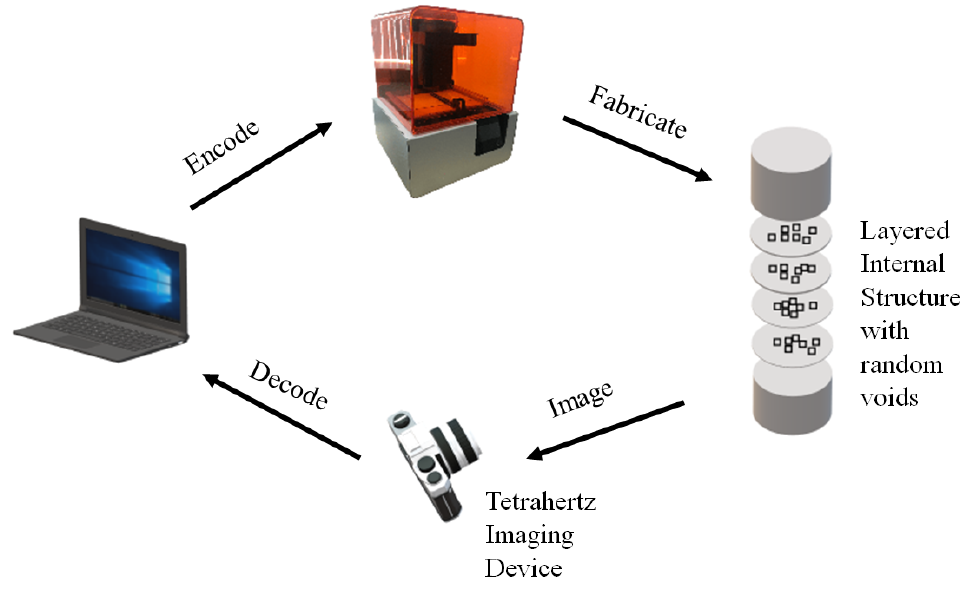
Figure 7. Infrastructs pipeline